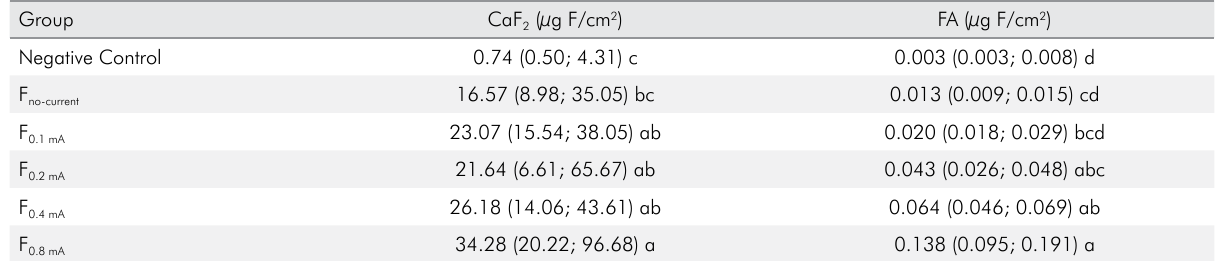
Table 2. Median values (minimum and maximum value) of calcium fluoride (CaF according to the treatments (n